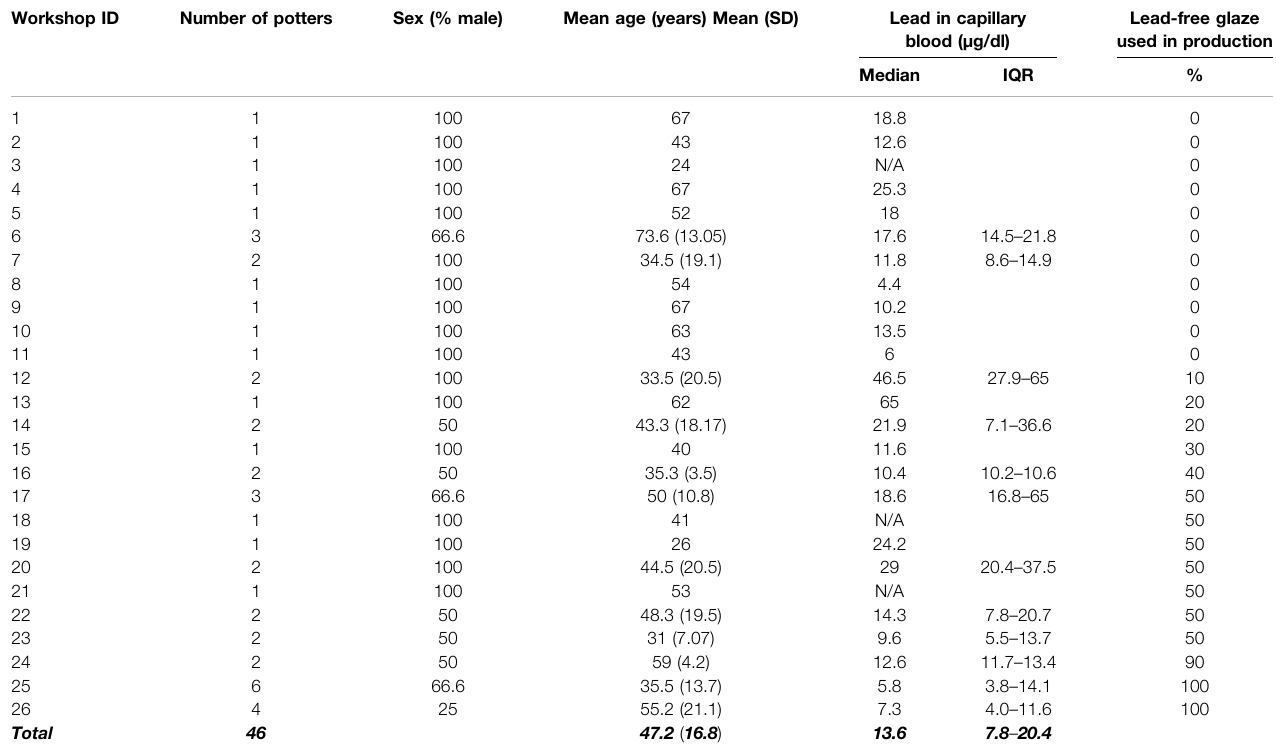
TABLE 1 | Detailed description of the